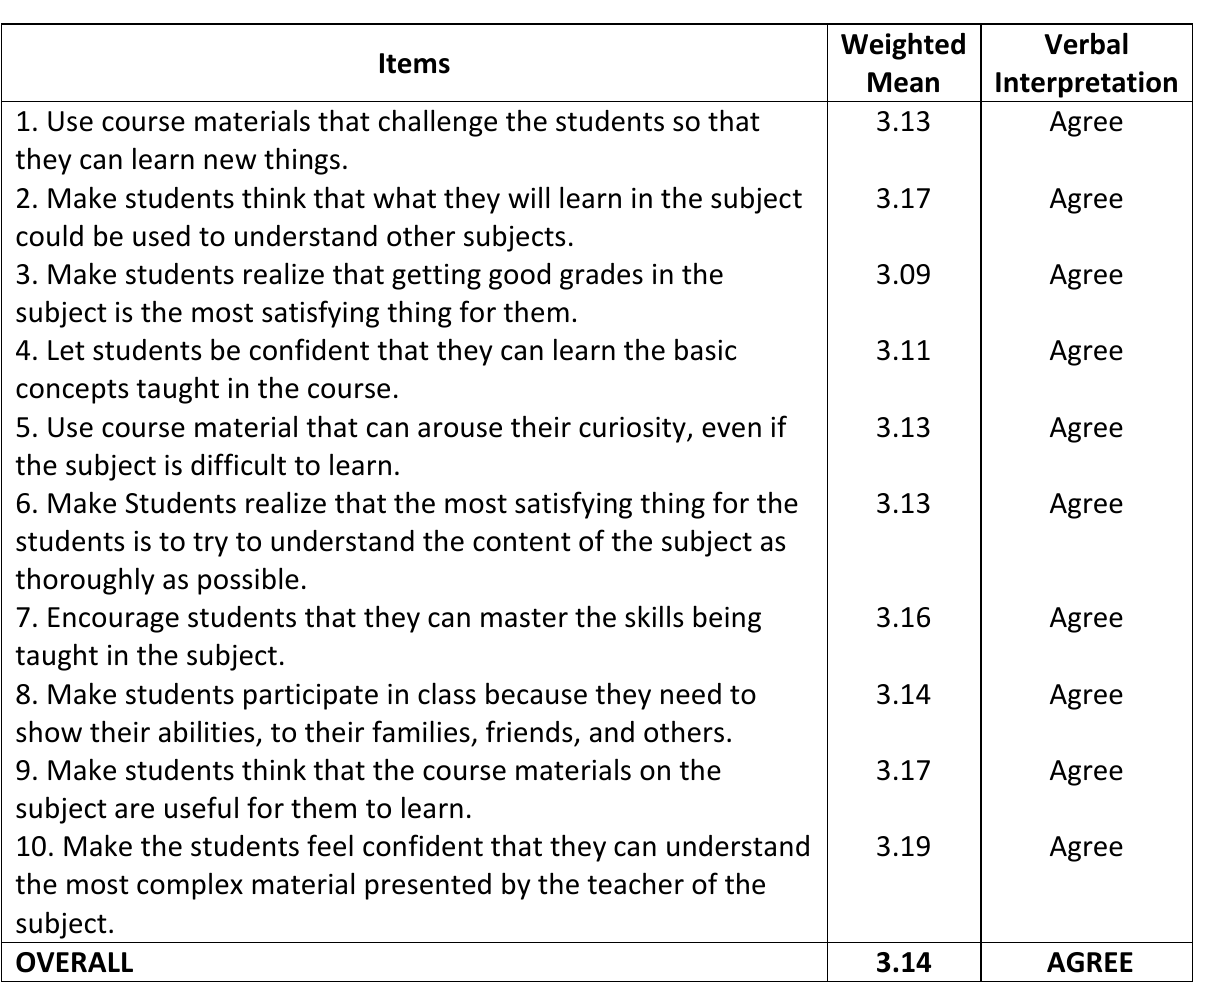
Table 6 : Weighted Means of the Factors Affecting Students’ Progress as to Motivation to Learn